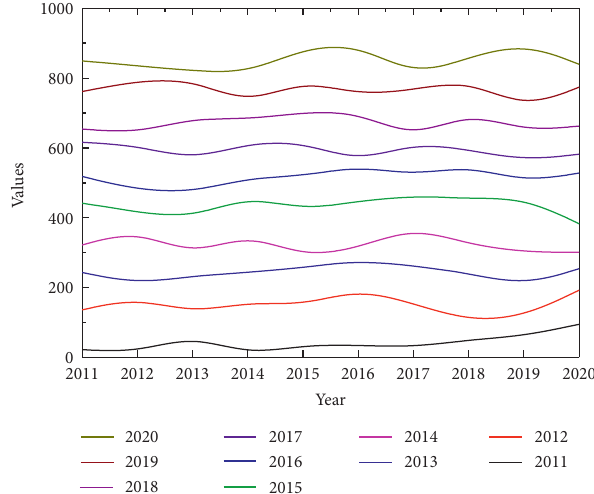
Figure 7: Sample distribution of the expanded LSUN data set, indicating the scene type.